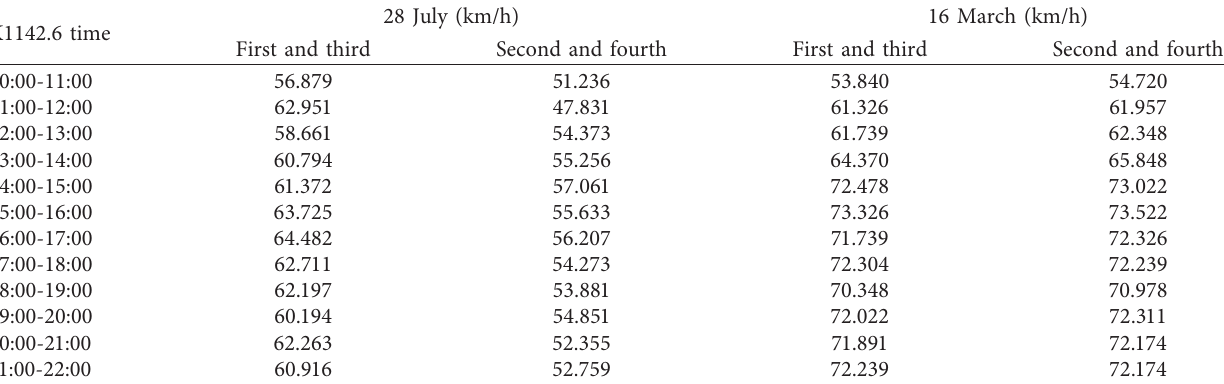
Table 2: Average speed of K1142.6 at 10 a.m. to 9p.m.